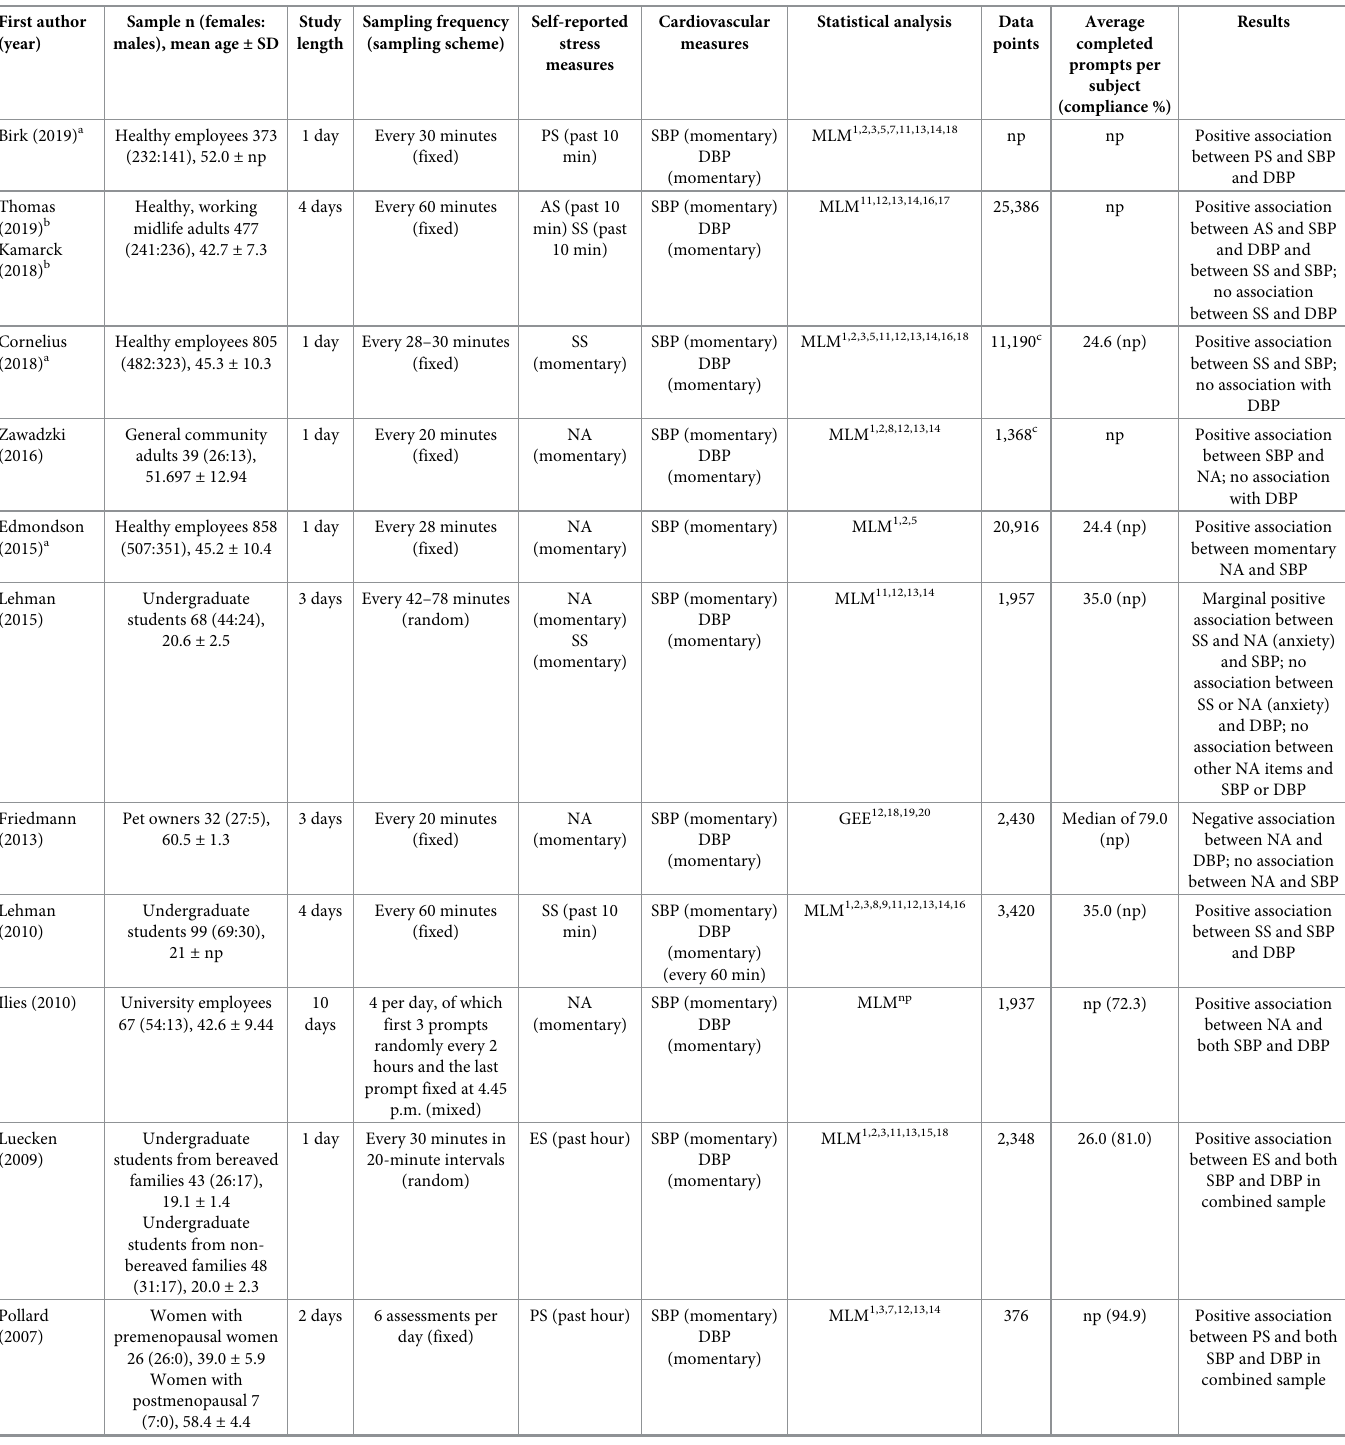
Table 2. Associations with ambulatory blood